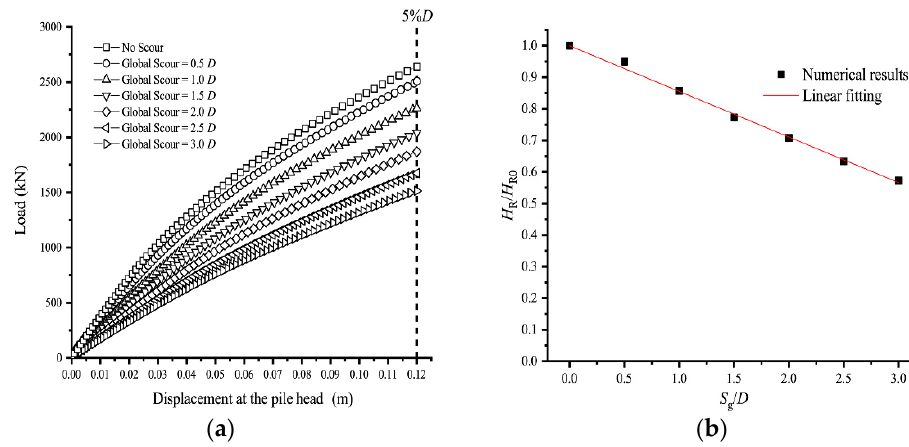
Figure 5. Global scour effects on ( a ) load-displacement curves and ( b ) pile capacities.